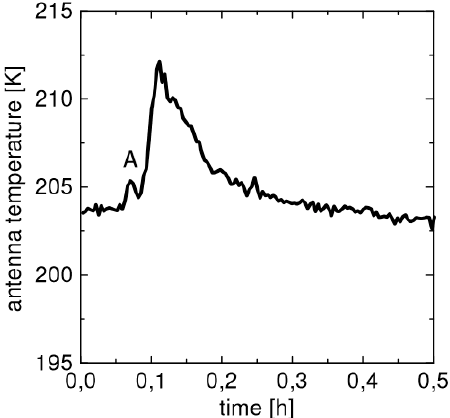
Figure 3. Antenna temperature recorded during an experiment carried out to detect a fire spot. The relative maximum A on the left of the main peak is caused by the person lighting the fire and falling inside the antenna beam, at a distance of 30 m from the antenna sensor. After [12].